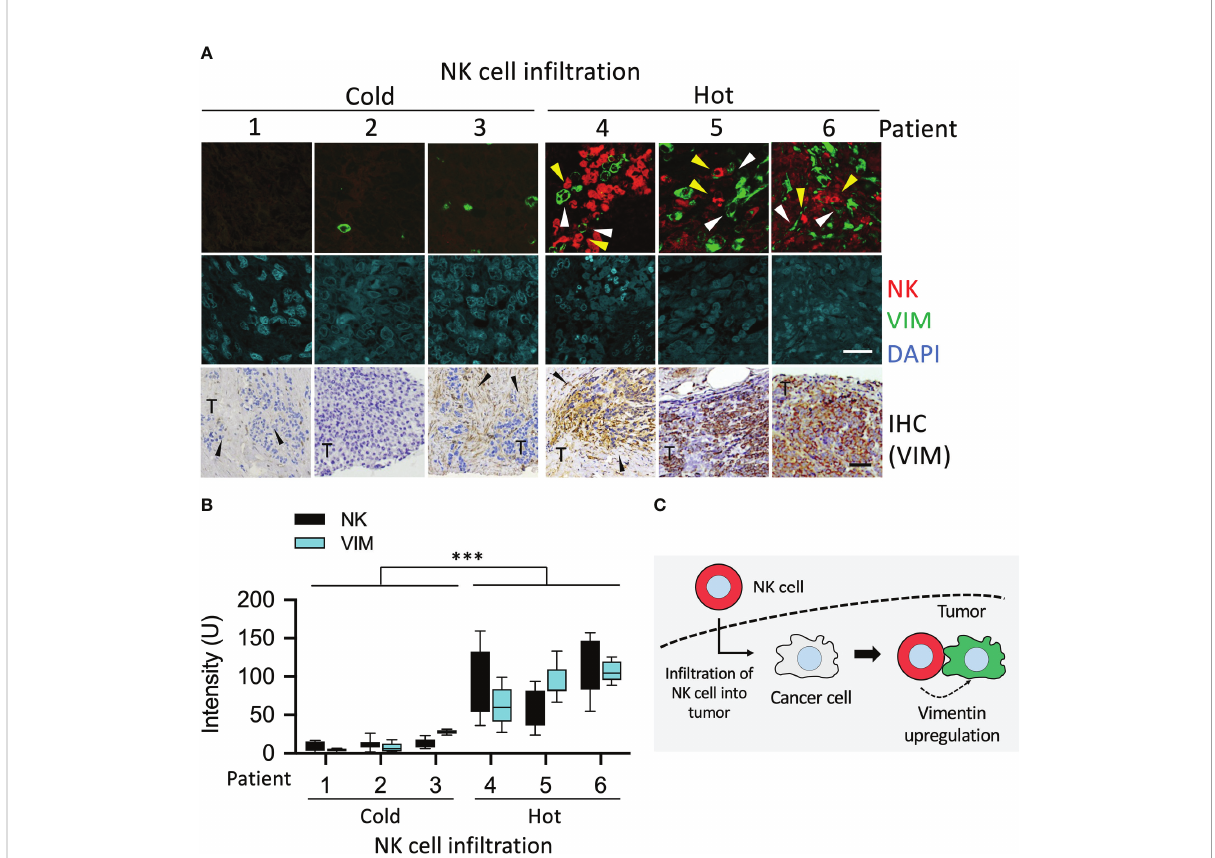
FIGURE 6 Upregulation of vimentin in NK cell in fi ltrated tumor of UTUC. (A) Different levels of NK cell-in fi ltrated tumors from patients with UTUC were collected. The tissue sections of UTUC were co-stained with NK1.1 and vimentin antibodies followed by detection of fl uorescence signals using a confocal fl uorescence microscope. Vimentin was also detected using immunohistochemistry staining. (B) The fl uorescence intensity of NK1.1 and upregulated vimentin in the tumor was quanti fi ed by ImageJ. *** P < 0.001. Data are presented as means ± s.d. (two-way ANOVA) from three fi elds (n = 3). (C) Schematic represented the upregulation of vimentin induced by NK cells. Yellow arrowhead, NK cell; white arrowhead, vimentin. White scale bars, 50 µm, Black scale bars, 100